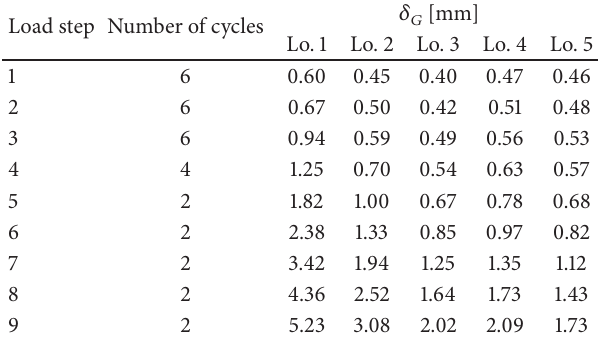
Table 3: Loading protocol details. Load step Number of